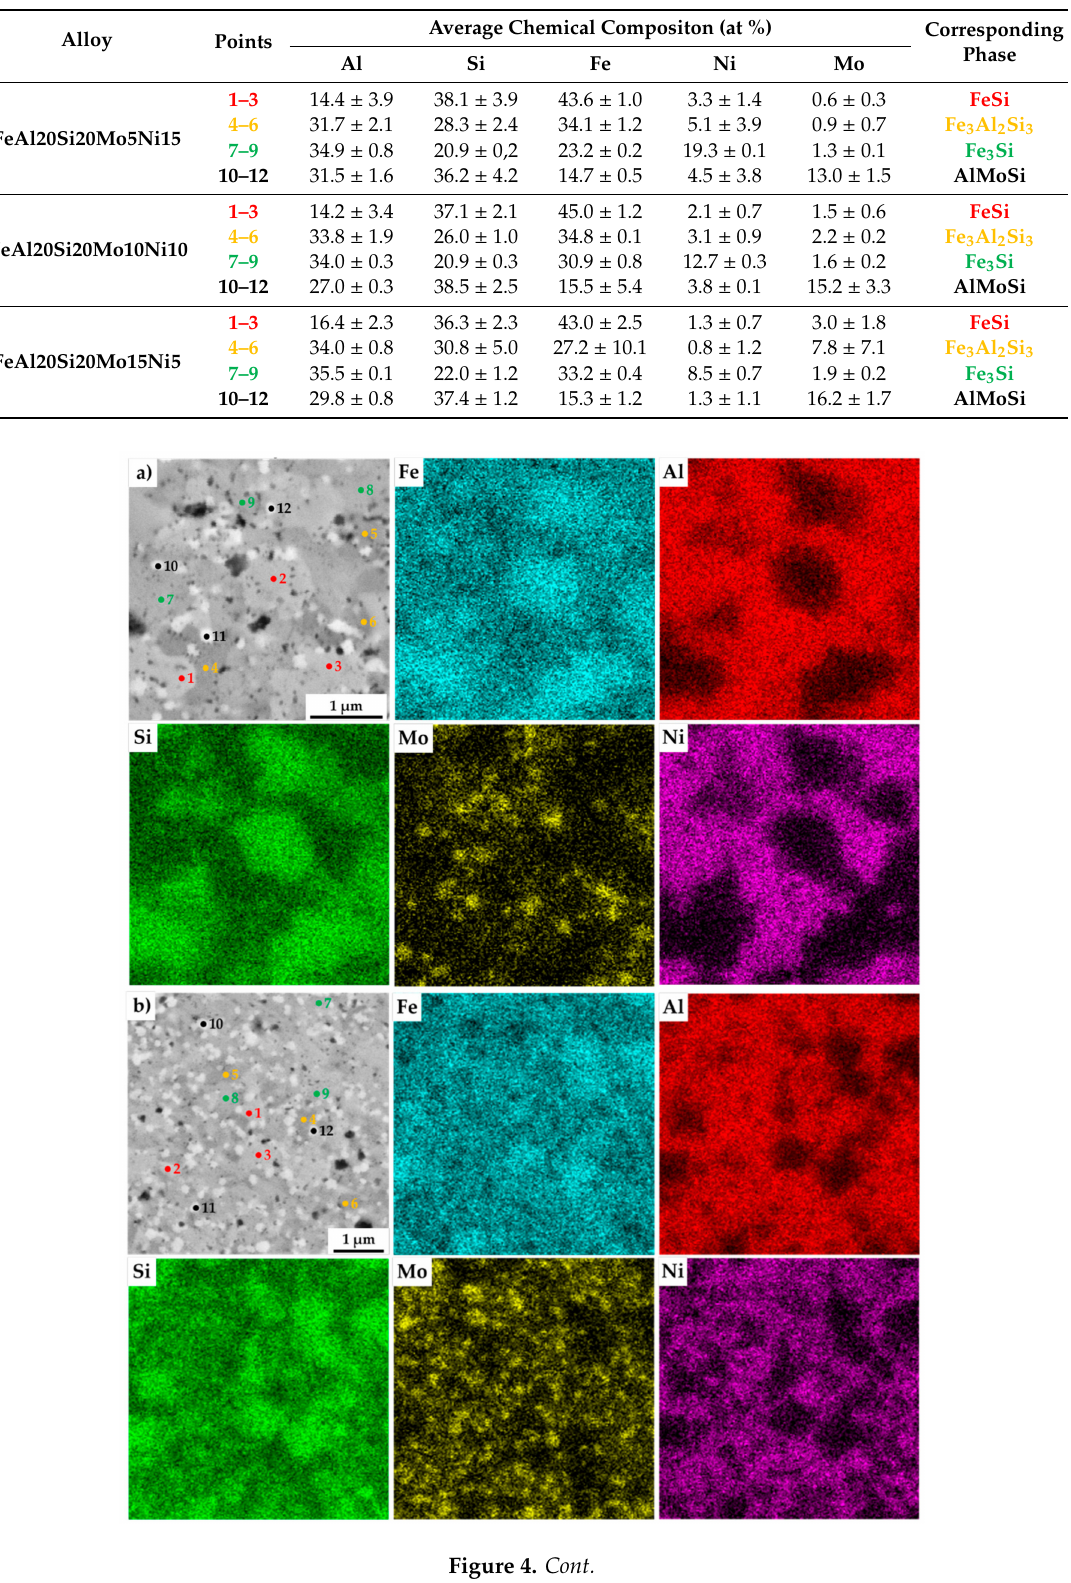
Table 3. Results of the SEM + EDS analysis of the points marked in Figure 4.